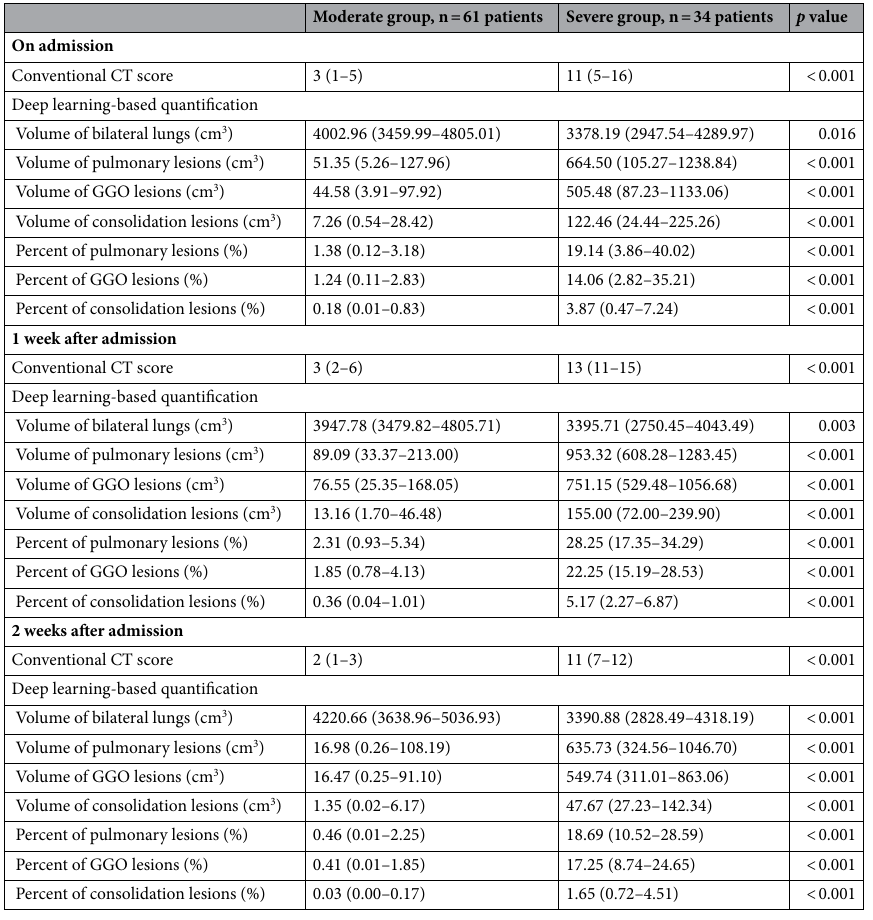
Table 4. Comparisons of CT score and deep learning-based quantification between moderate and severe groups at different time